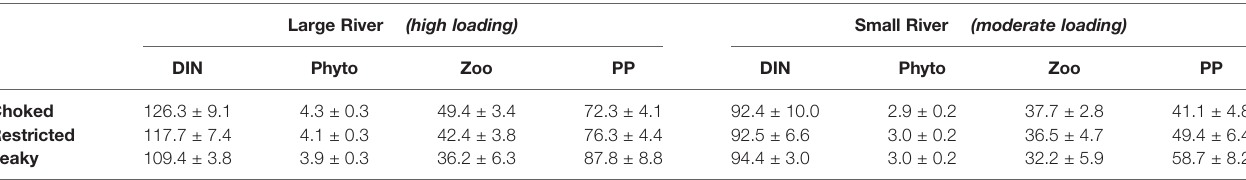
FIGURE 2 | Mean ( ± SD) net total nitrogen (N) export to the coastal ocean as a function of river discharge and bay morphology under the “ no aquaculture ” scenarios. Error bars represent variability introduced by other factors ( i.e. climate). TABLE 2 | Main pelagic model variables and rates (annual mean ± SD) in scenarios without